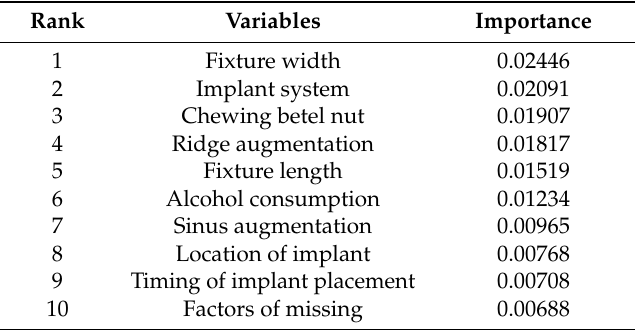
Table 5. Importance of the